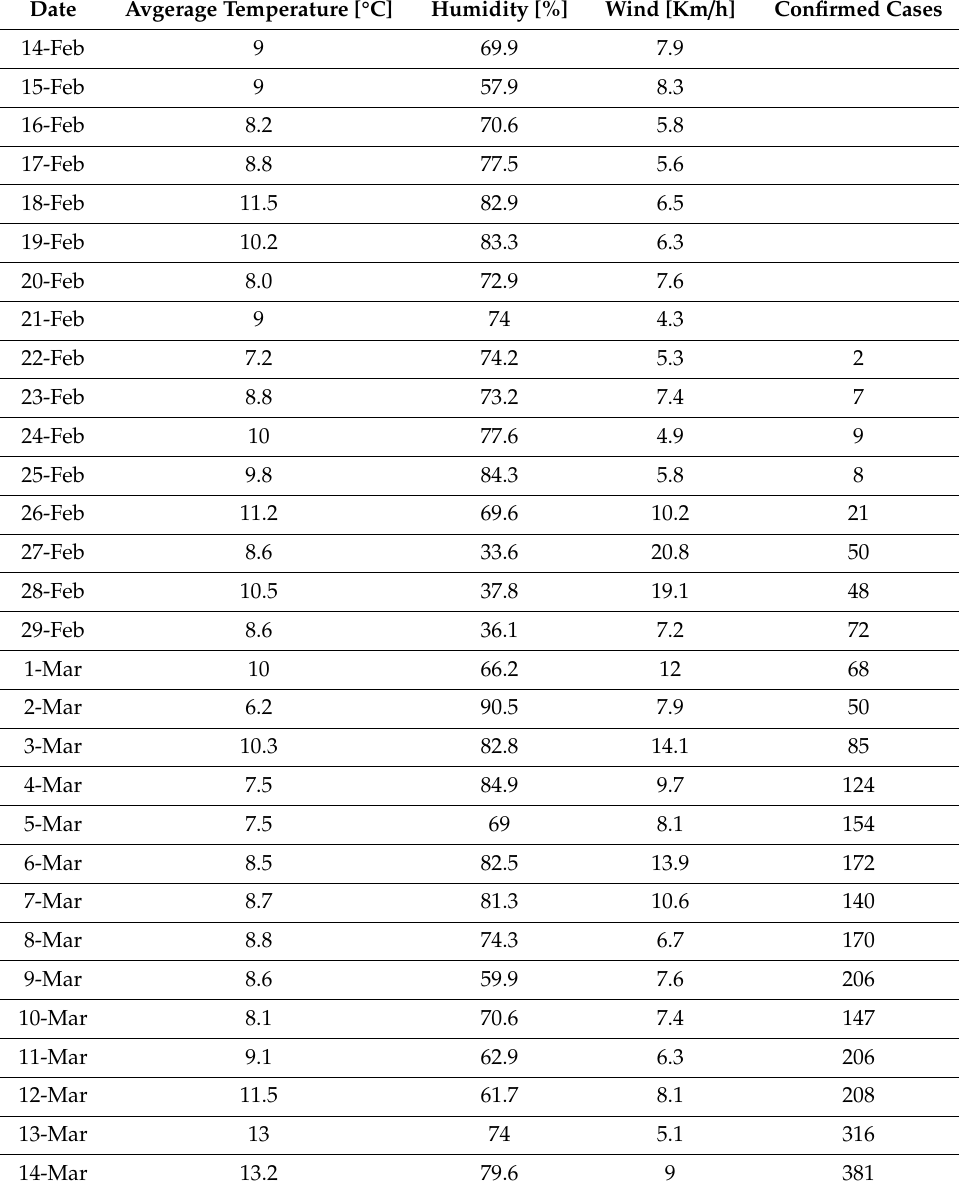
Table A3. The dataset of Emilia-Romagna (Bologna),